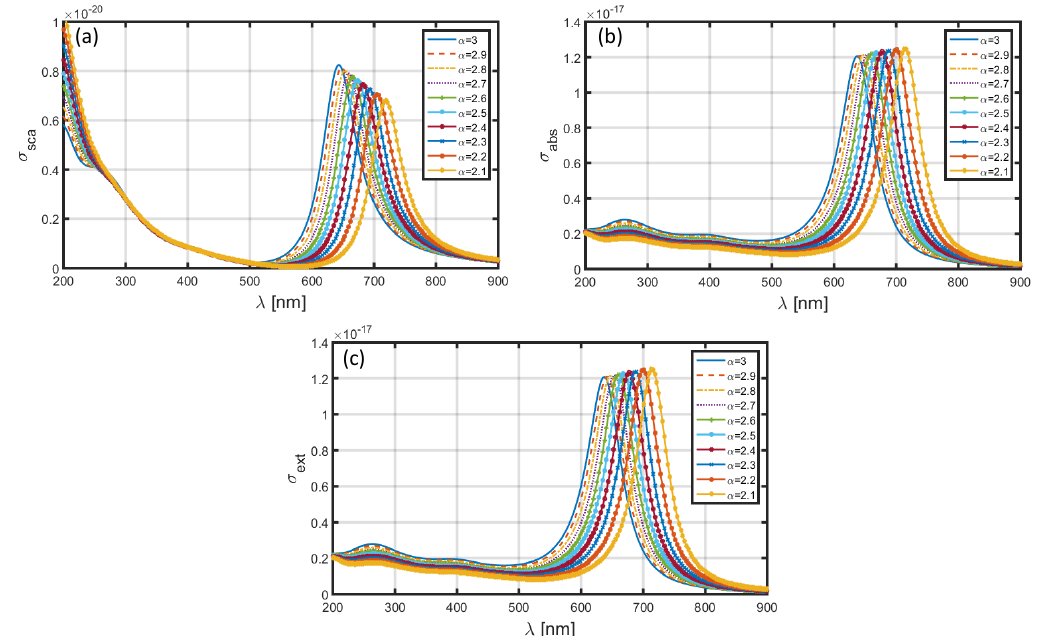
Figure 8. Plots of ( a ) scattering cross-section, ( b ) absorption cross-section, and ( c ) extinction coe ffi cient against λ for SiO 2 -Au nanoparticle in the FD space corresponding to the dimensions a = 1.6 nm, b = 2 nm.